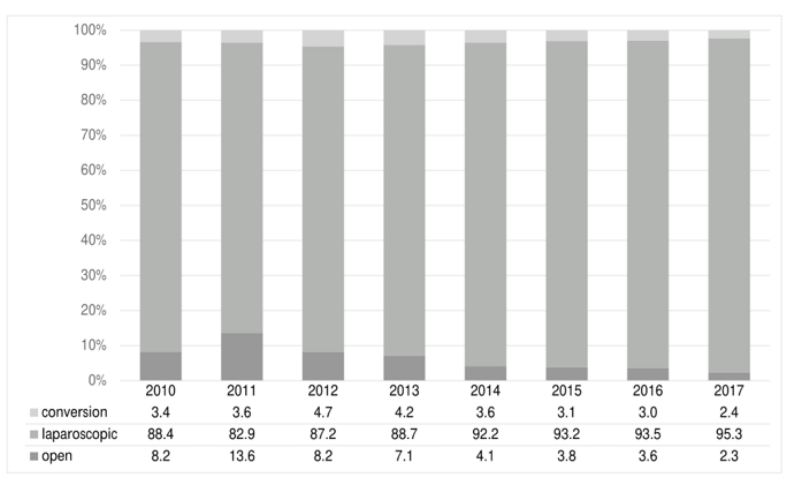
Figure 6. Operation type and conversation rate (%), 2010–2017 ( n = 19,749).